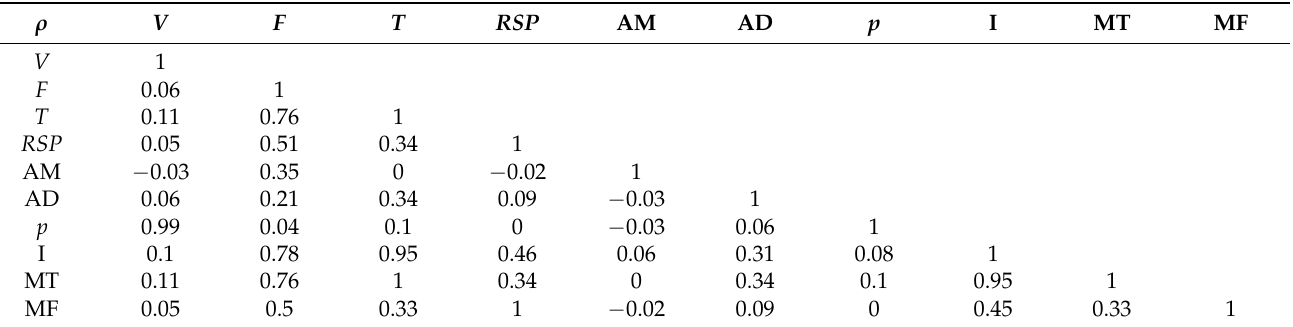
Table 2. Table 2. Correlation analysis results of randomly sampled